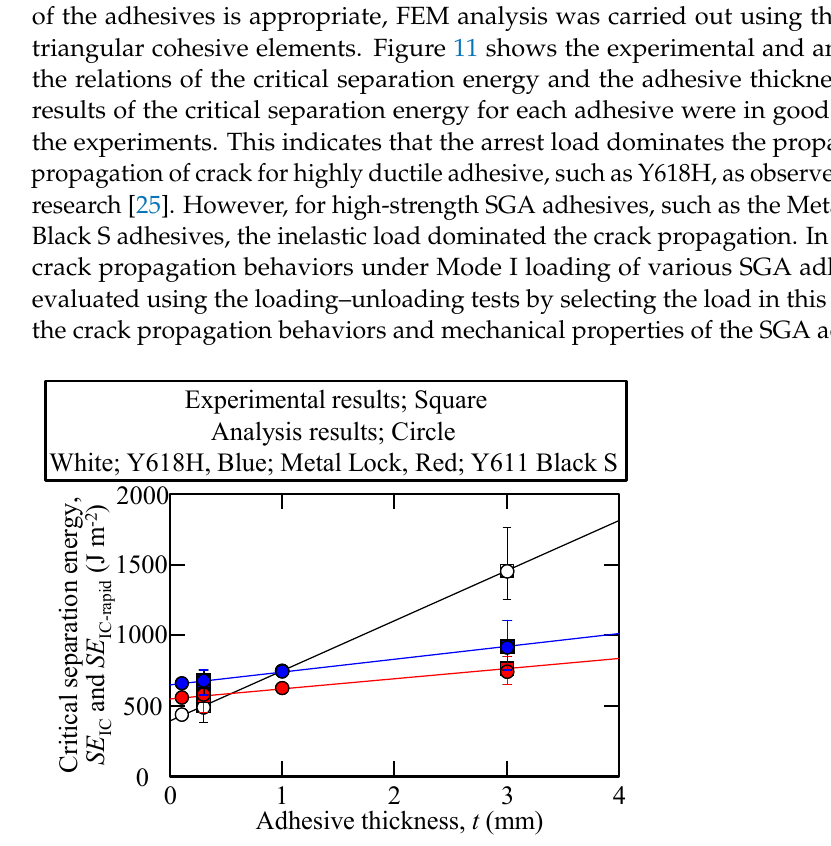
Figure 11. Analysis results showing the variation of the critical separation energy with respect to the adhesive thickness.